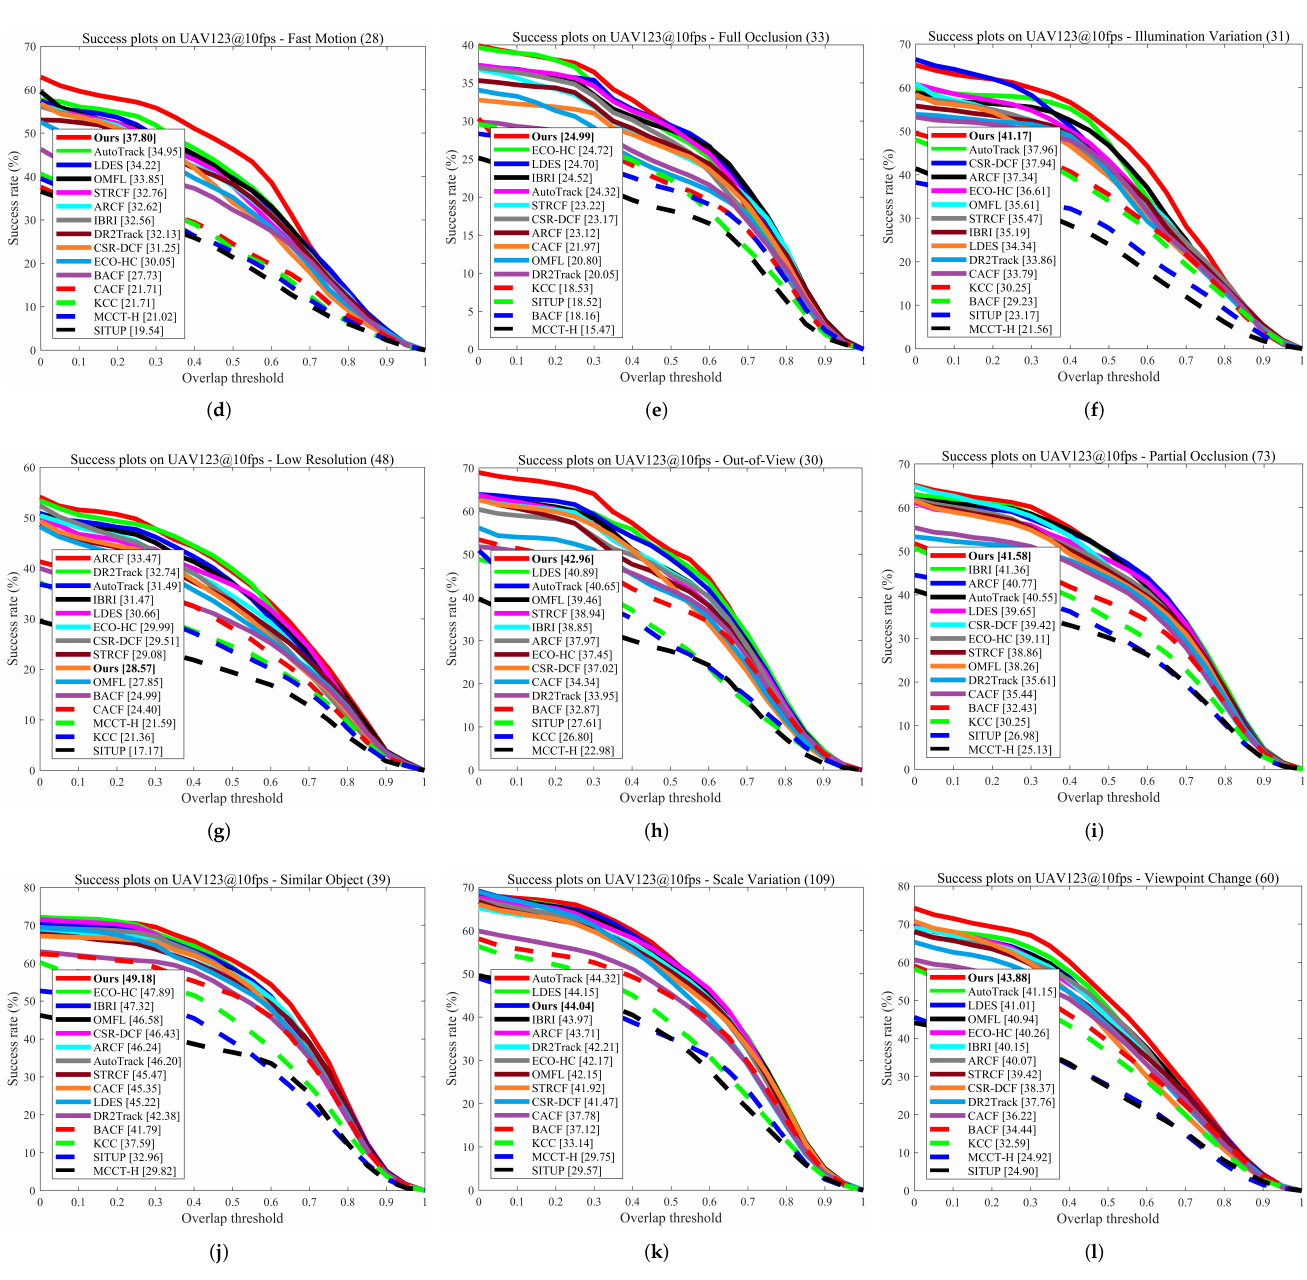
Figure 10. Success plots on different attributes of the UAV123@10fps [45] benchmark. ( a ) Aspect ratio change. ( b ) Background clutter. ( c ) Camera motion. ( d ) Fast motion. ( e ) Full occlusion. ( f ) Illumination variation. ( g ) Low resolution. ( h ) Out-of-view. ( i ) Partial occlusion. ( j ) Similar object. ( k ) Scale variation. ( l ) Viewpoint